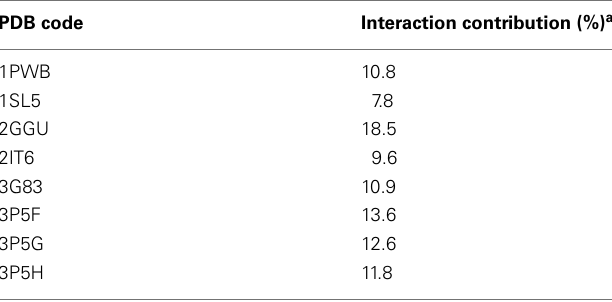
Table 4 | Contributions to ligand recognition made by metal ions in